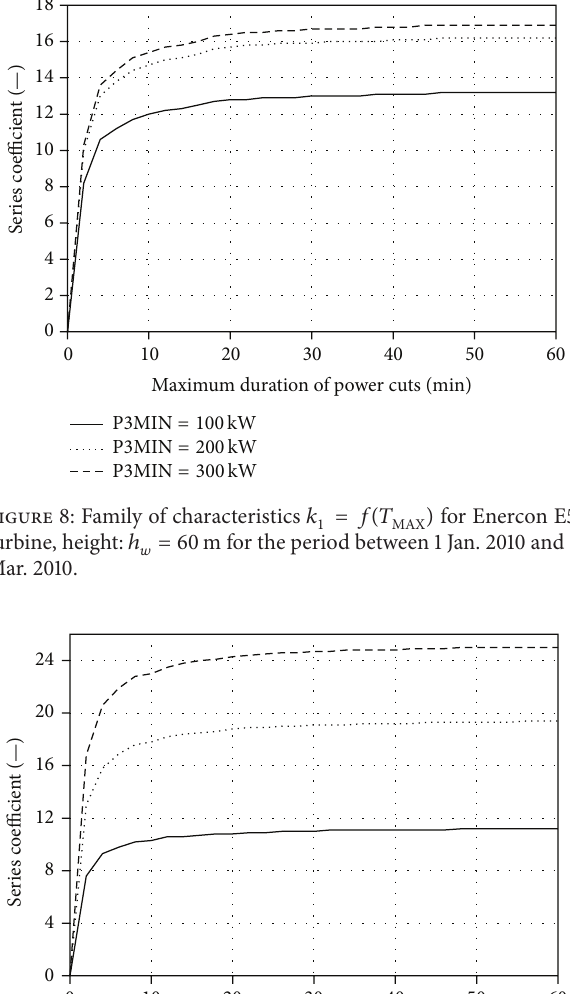
) for Enercon E53 MAX